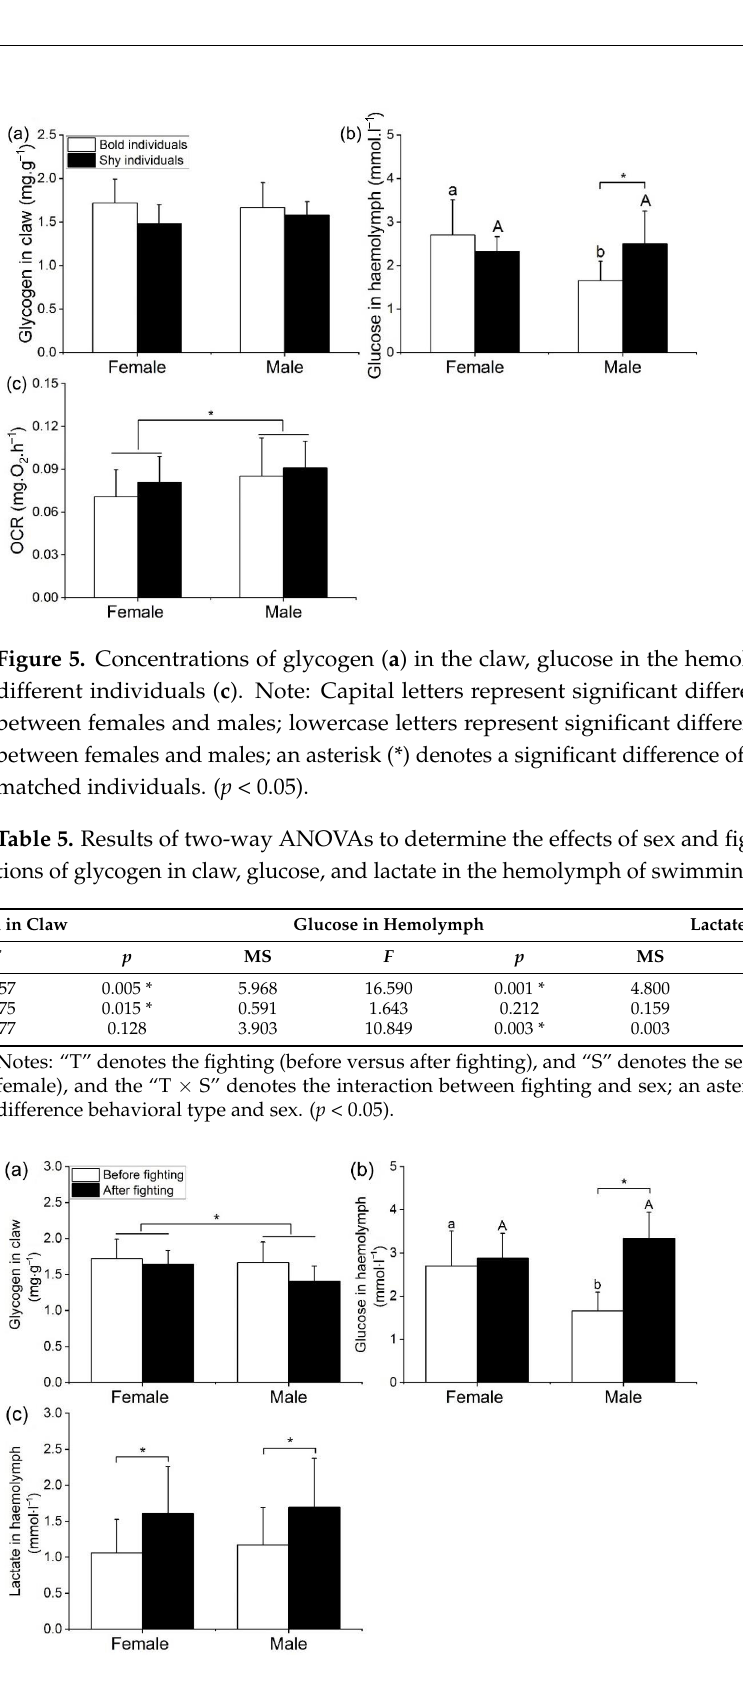
Figure 6. The mean concentrations of glycogen ( a ) in claw, glucose ( b ) and lactate ( c ) in the hemolymph before and after fighting. Note: Lowercase letters represent significant difference of concentrations between females and males before fighting; uppercase letters represent significant difference of concentrations between females and males after fighting; an asterisk (*) denotes denote a significant difference before and after fighting ( p < 0.05).